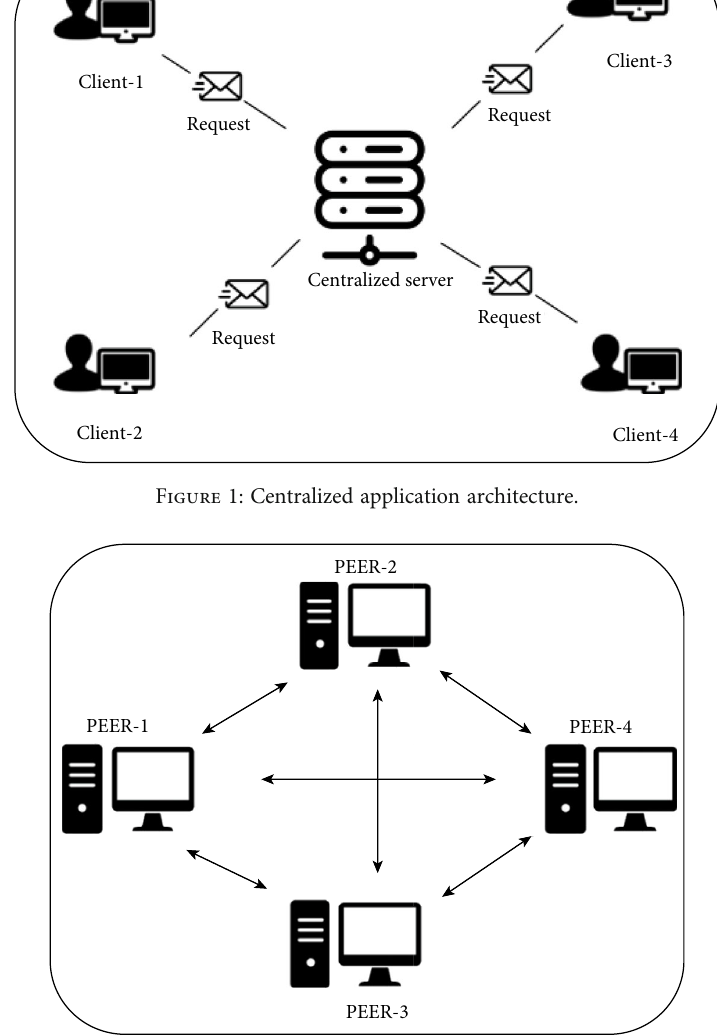
Figure 2: Decentralized application